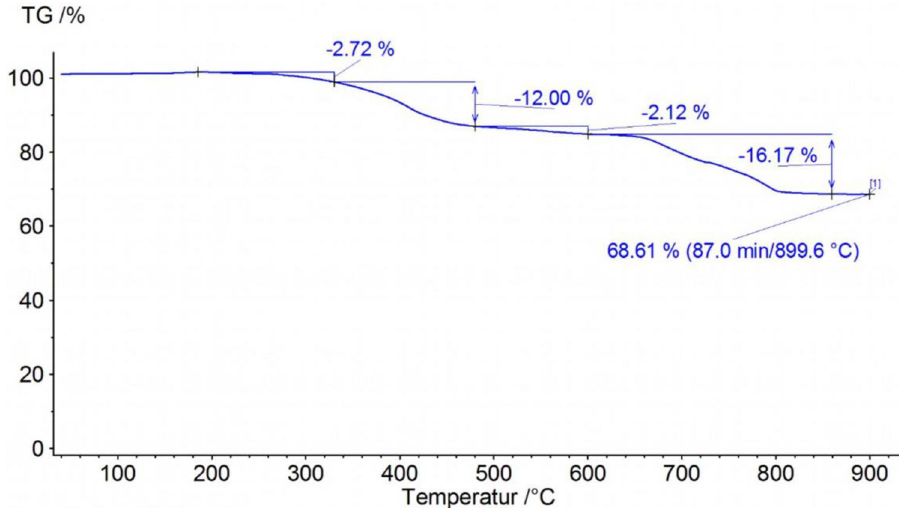
Figure 3. Thermogravimetric analysis of TWAP.